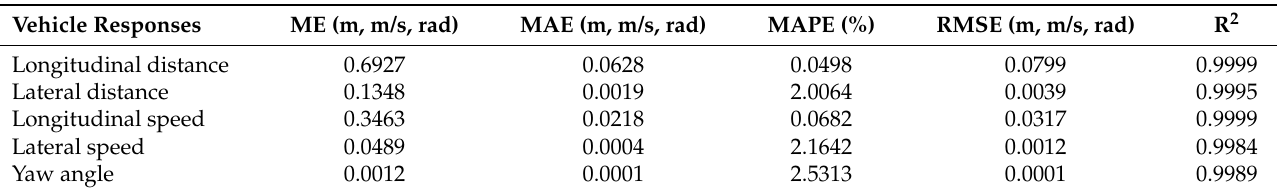
Table 1. The accuracy of the DNN model.